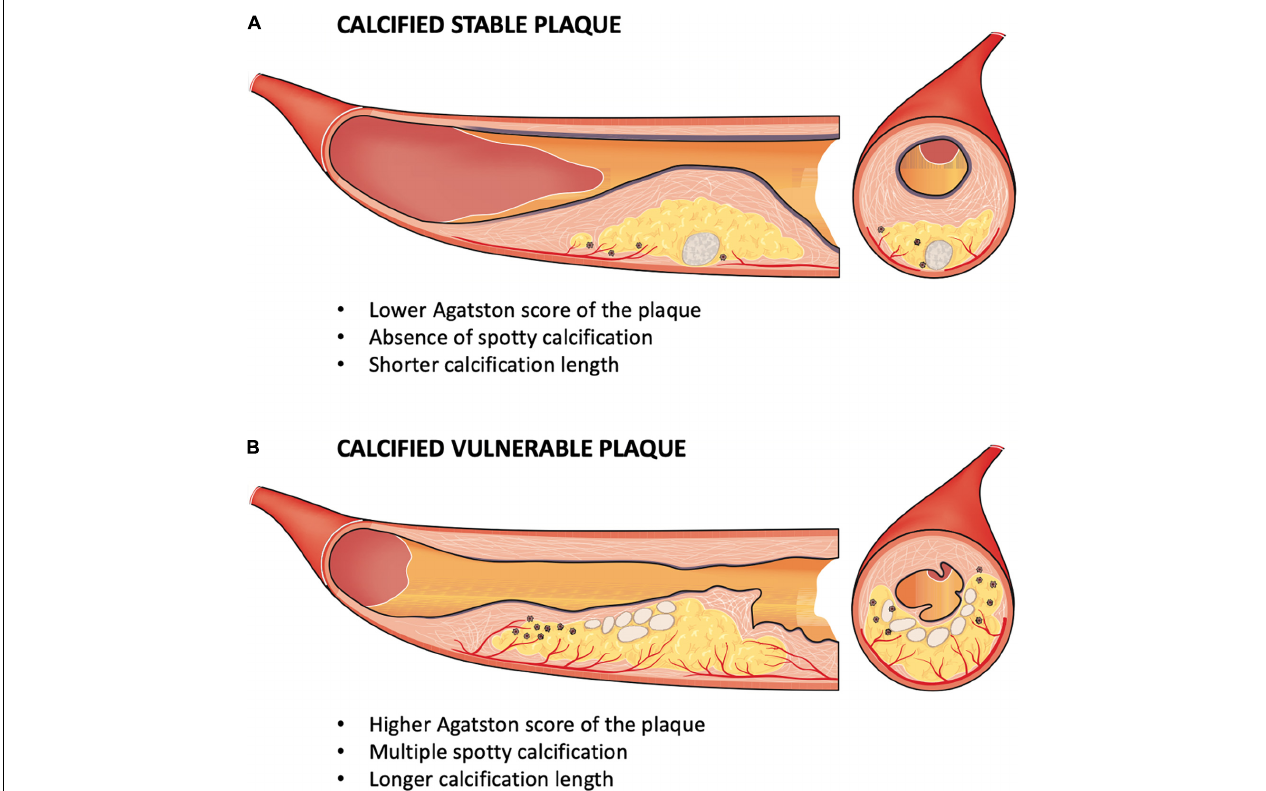
FIGURE 5 | Physical and geometric model of the calcium component of vulnerable plaques. (A) Calcified stable plaque had a smaller total calcium volume, a lower density (HU), a lower Agatston score of the plaque (ASp; longitudinal section – to the left); a more eccentric position and a higher sphericity index (axial section – to the right). (B) Calcified vulnerable plaque had a larger total calcium volume, a higher density (HU), a higher ASp and multiple spotty calcifications (longitudinal section – to the left); a more intimal position leading to mechanical stress and with a smaller sphericity index, corresponding to more oval calcifications (axial section – to the right). Abbreviations: Asp, Agatston score per calcified plaque; HU, Hounsfield